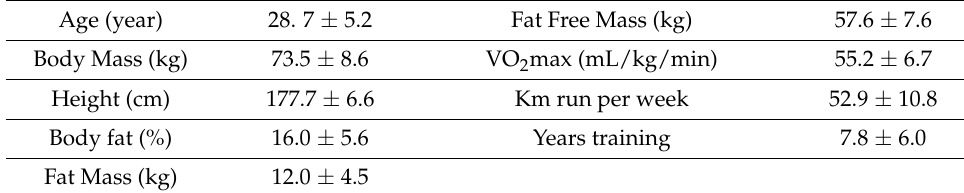
Table 1. Baseline Characteristics 1